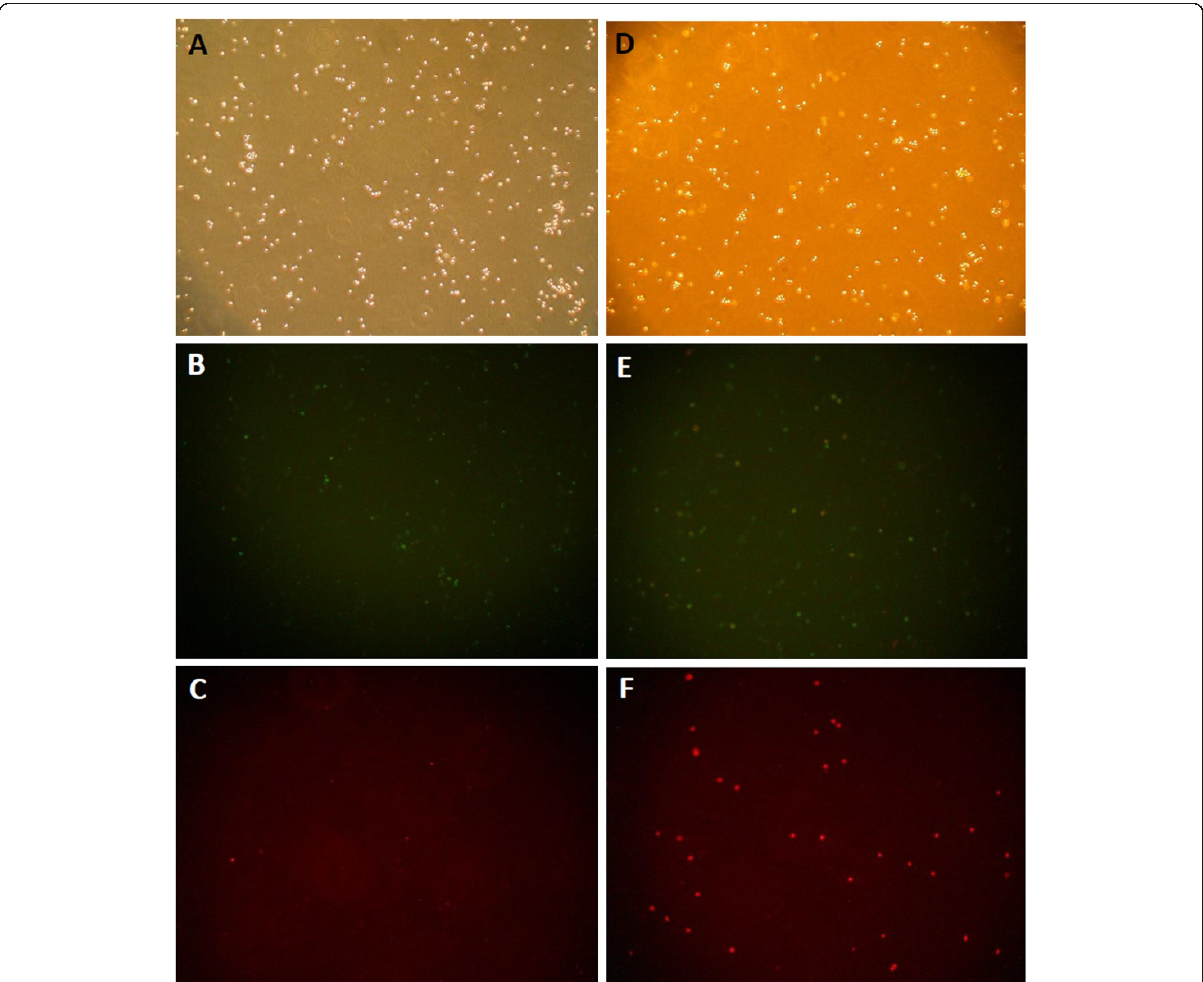
Figure 6 Fluorescence microscopy of HeLa cells treated with crude aqueous root extracts of P. indica for 48 hours and double stained with annexin-V-sensitive probe (conjugated to FITC) and propidium iodide. Qualitative labeling of annexin V in the plasma membrane ( B and E ) or cellular uptake of propidium iodide ( C and F ) was recorded. Control cells exposed to PBS ( A )-( C ), and 0.5 mg/ml of crude aqueous extracts treated cells ( D )-( F ) were photographed with a microscope (×